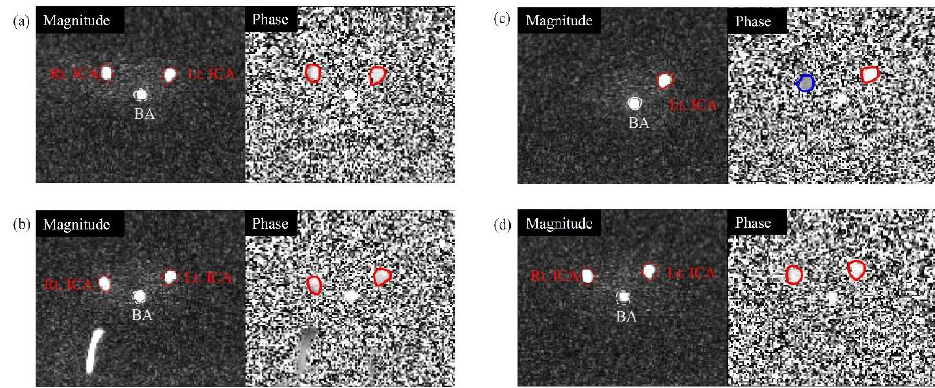
Figure 6. Representative slices for the analysis of the ICA flow directions at VENC = 50 cm/s (magnitude and phase images on the left and right, respectively): ( a ) normal phantom; ( b ) right ICA 50% stenosis phantom (ICA50); ( c ) right ICA 100% occlusion phantom (ICA100); and ( d ) right VA 100% occlusion phantom (VA100). The phase images were obtained from a superior–inferior encoding direction. The red lines represent the normal flow of the ICA, and the blue line represents no flow.